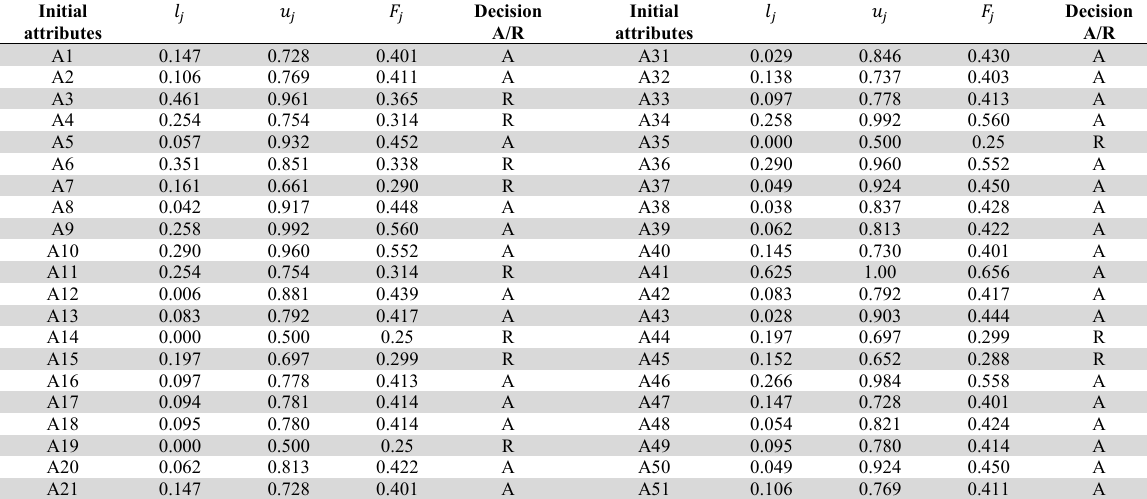
Factors screening out after FDM round